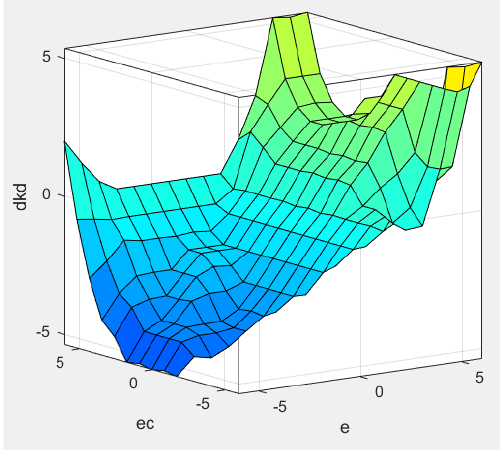
k  output surface. Figure 5. ∆ k d output surface. d